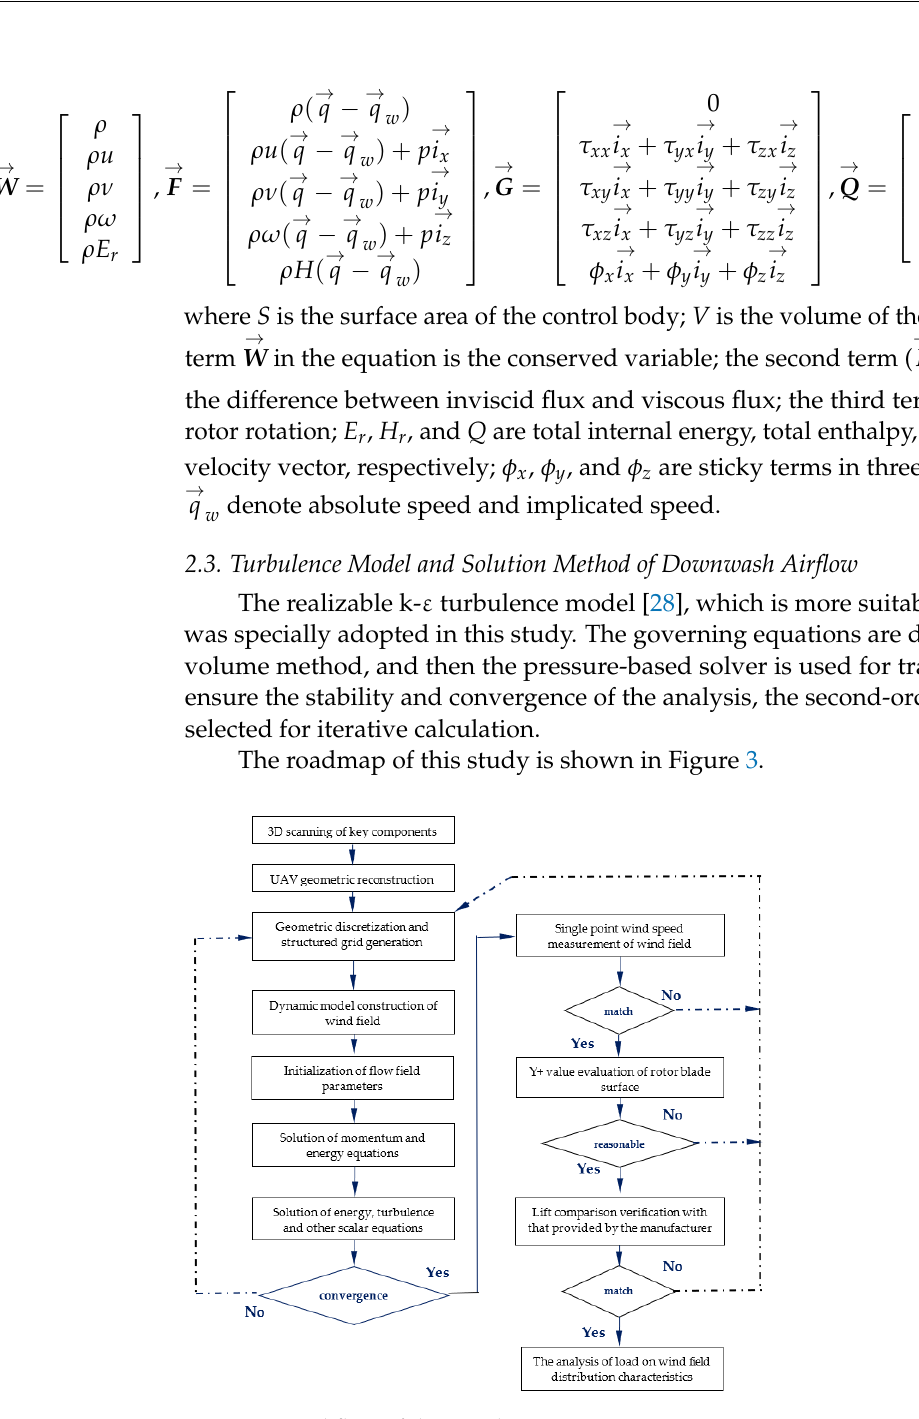
Figure 3. Workflow of this article.